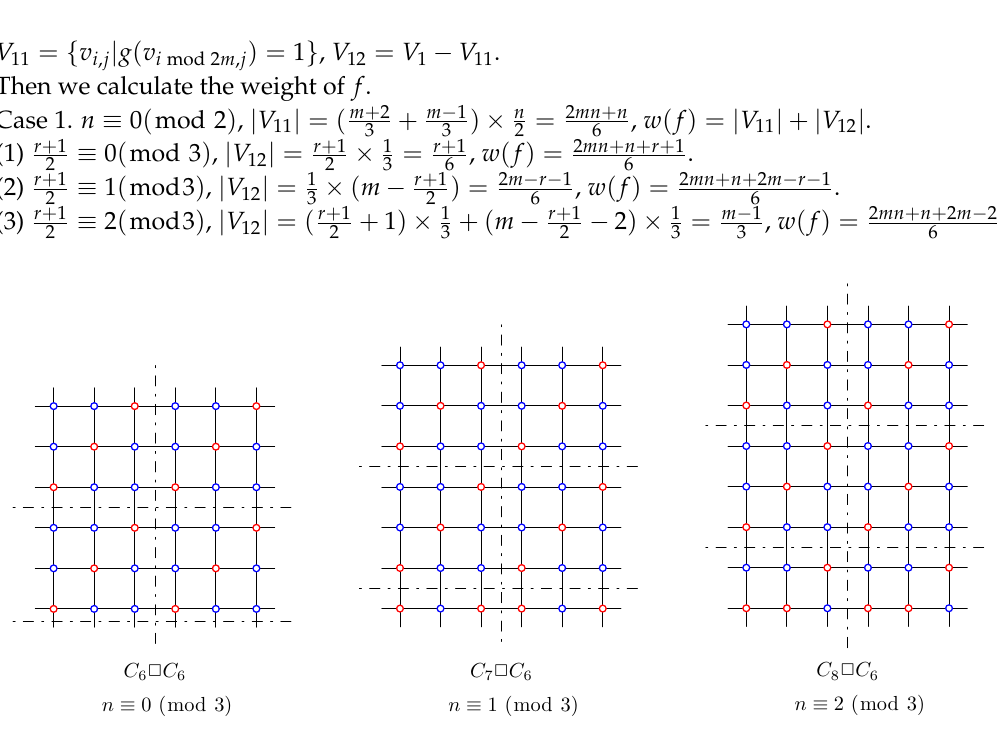
0 ( mod3 ) . Above the last horizontal dashed line, the block separated 1 ( mod3 ) . Figure 3. f on C n (cid:50) C m for m ≡ ≡